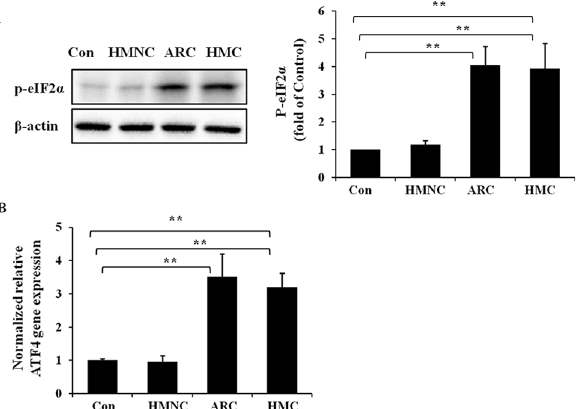
Fig 4. Up-regulation of p-eIF2 α protein level and ATF4 gene expression level in the lens epithelium of HMC patients. RNA and protein were extracted from HMC, HMNC, ARC or normal control (Con) human epithelium specimens. Western blotting was performed to detect the protein expression of p-eIF2 α (Fig 4A), and β -actin was used as the internal control. Real-time PCR was performed to detect the relative gene expression level of ATF4 in each group (Fig 4B), and 18S was used as the internal control gene (mean ± SD, n = 3). * P < 0.05; ** P <